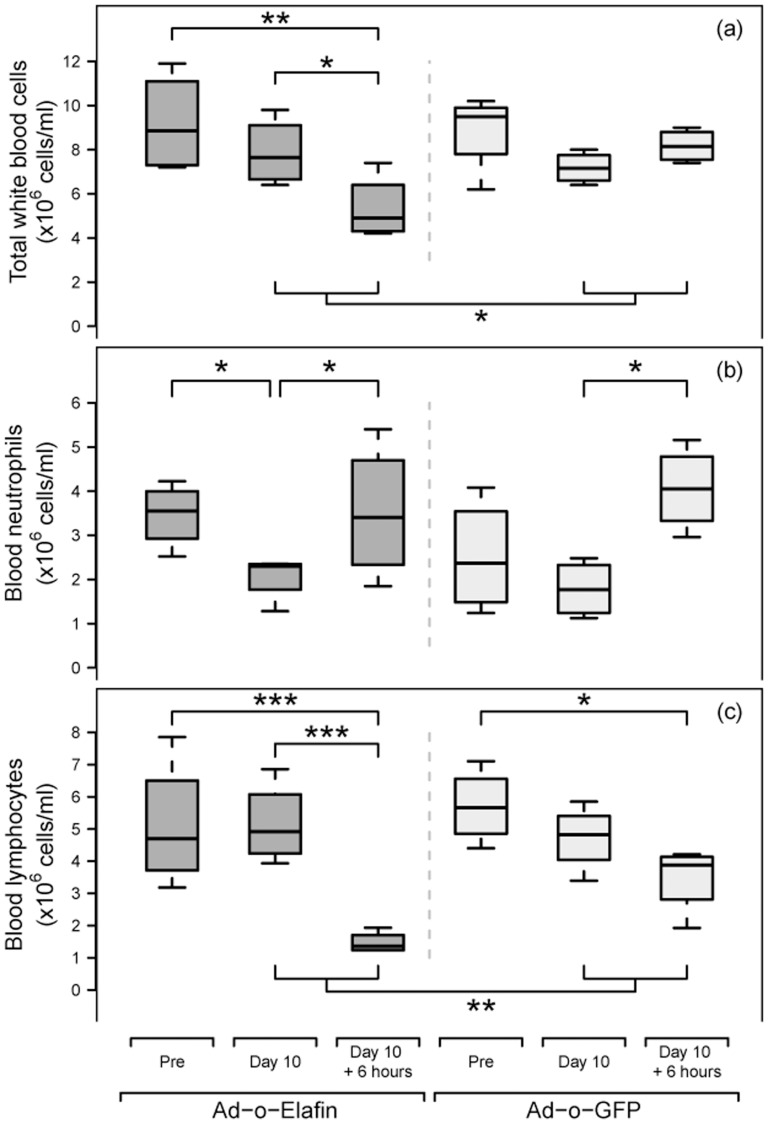
Systemic haematological responses to intrapulmonary adenoviral vector and LPS administration.Heparinised blood was collected by venepuncture at various time points throughout the experimental period (Pre-treatment (immediately prior to collection of baseline BALF samples), d10 and d10+6h). This blood was analysed for total white blood cell numbers, neutrophil numbers and lymphocyte numbers as indicated in a, b and c respectively. The boxplot tails reflect the range of data, the bottom and tops of the boxes the 25th and 75th percentiles respectively, and the thick horizontal line the median values. A linear mixed-effect model, where sheep-specific responses were assumed a random effect, was used to analyse the influence of Ad-o-elafin and Ad-GFP and subsequent LPS instillation on blood parameters. *, ** and *** represent P<0.05 and P<0.01 and P<0.001 respectively.